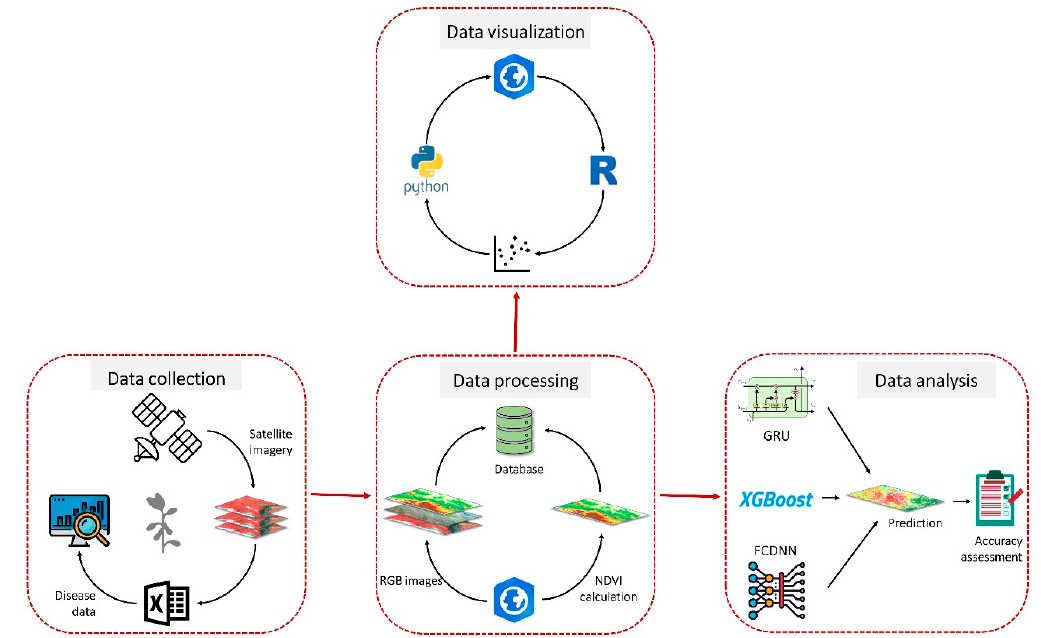
Figure 2. Flow diagram of the data collection, processing and analysis we employed in this study for sudden death syndrome (SDS) detection. We divided our methodology into four major steps including data collection, data processing, data visualization and analysis.